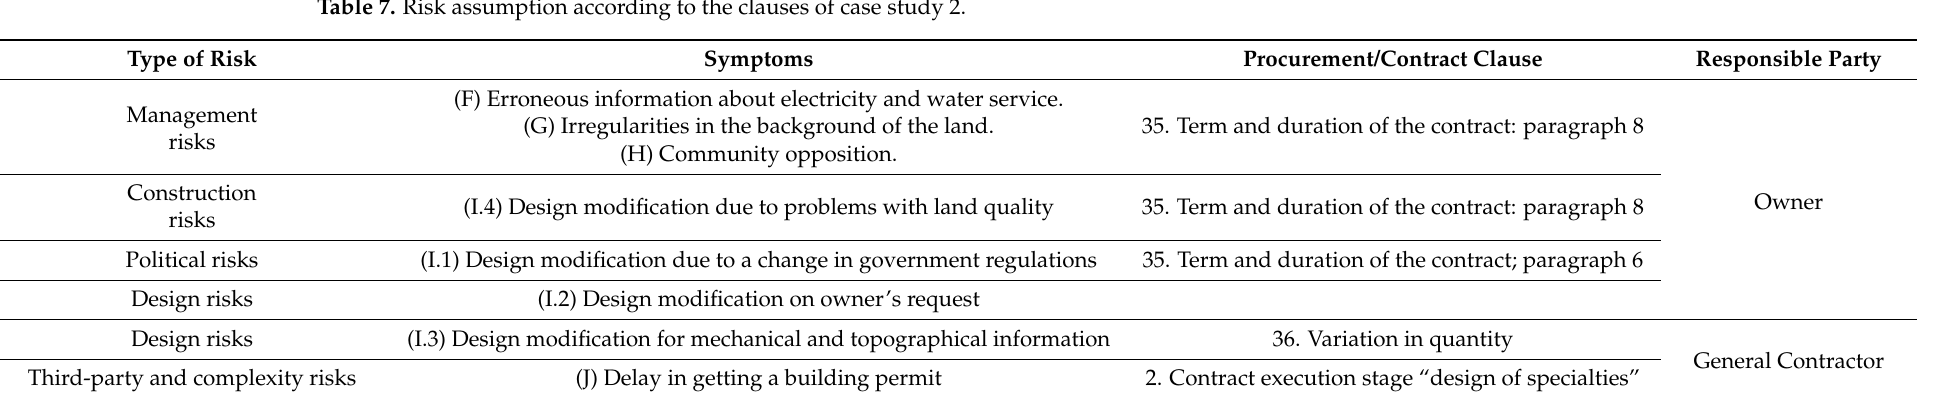
Table 7. Risk assumption according to the clauses of case study